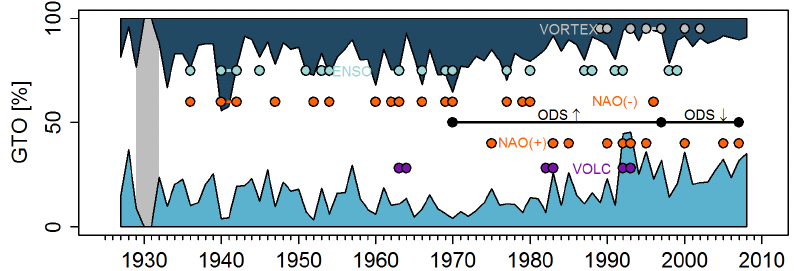
Fig. 10. Annual evolution of fractions of extreme events in low (ELOs – light blue area) and high (EHOs – dark blue area) total ozone and not extreme days (NEOs – white area). GTO is an abbreviation for Grouped Total ozone Observations. Colored circles show global modes distinguished by the following indices: ENSO (light blue), NAO (orange), volcanic eruptions of Gunung Agung, El Chich´on and Mt. Pinatubo (purple), polar vortex ozone loss (grey) and increasing/decreasing long-term development of ODS (black). Grey vertical bar denotes to a large fraction of missing data in 1929–1932. For references of atmospheric indices and other atmospheric quantities used see Part 2.